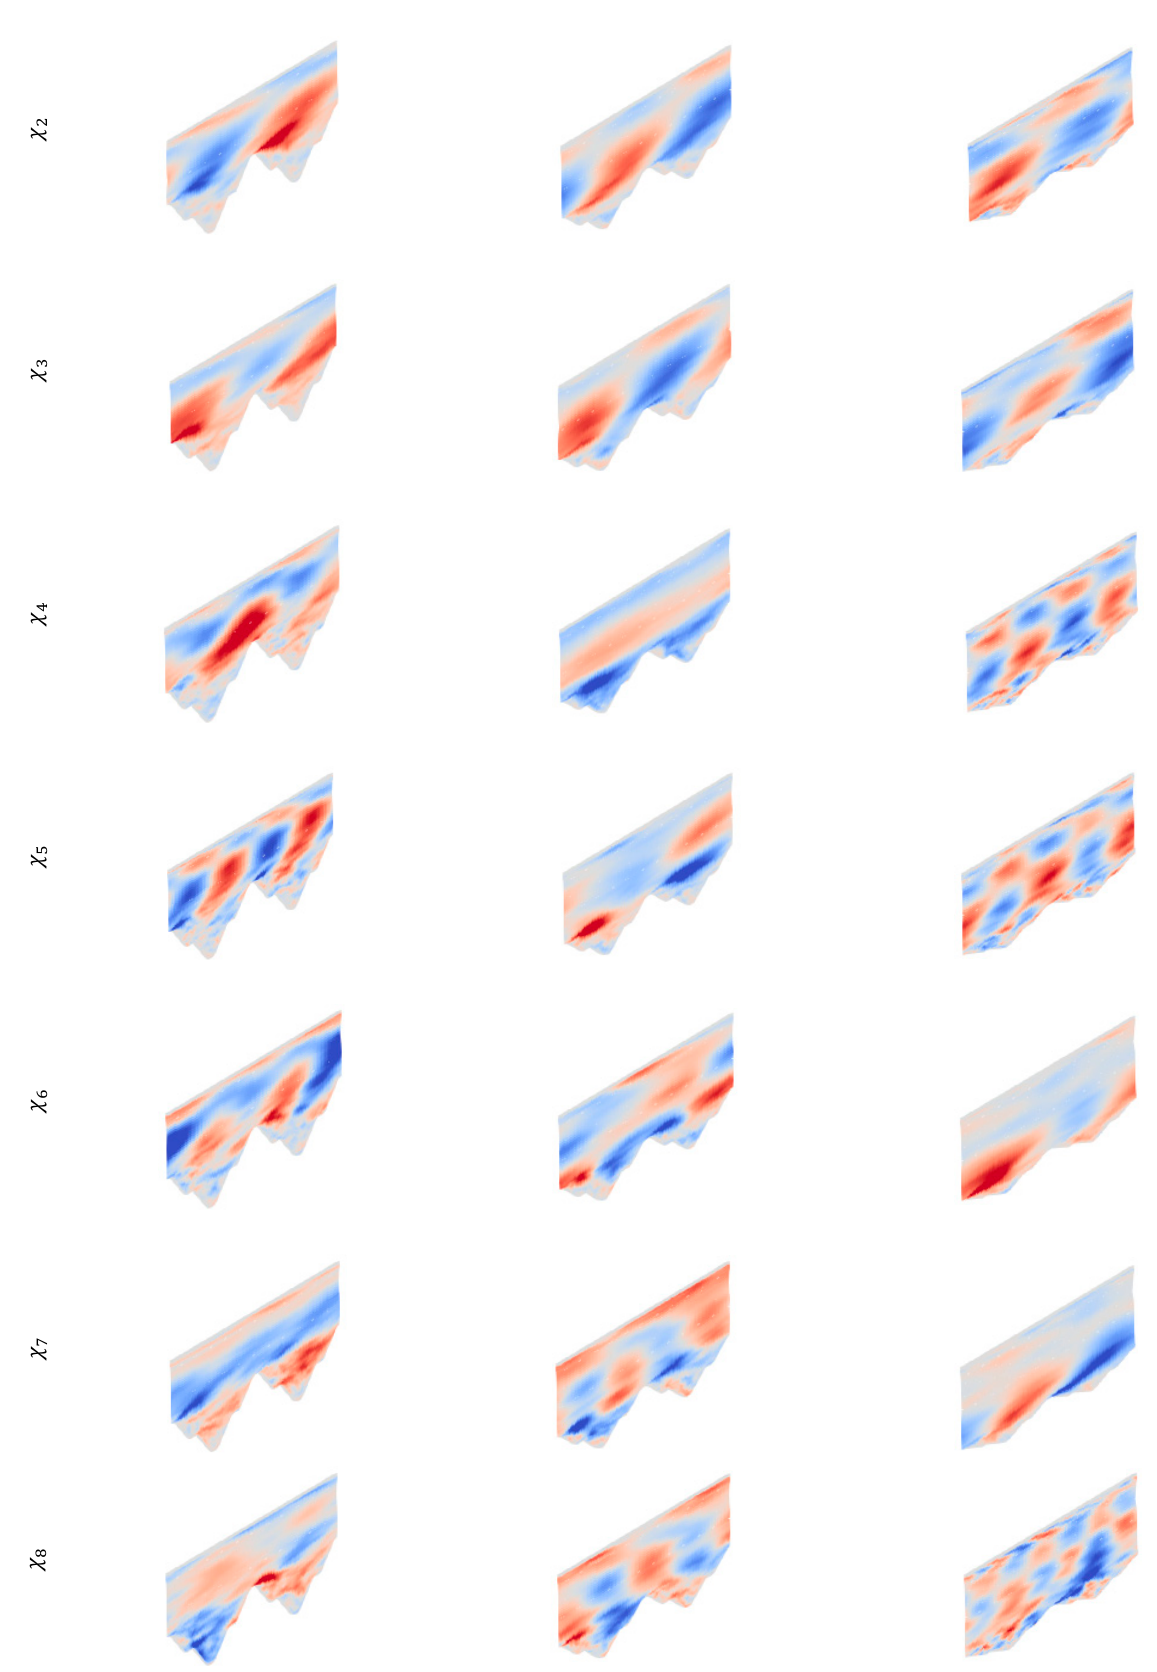
( c ) Figure 9. Front and back view of the temporal mean of the local Nu number for the three levels of roughness. ( a ) H = 60 μm ; ( b ) H = 40 μm ; and ( c ) H = 20 μm. POD is applied on the Nu field over the rough surface to evaluate the footprint of the flow and thermal fields on the heat transfer characteristics of the roughness model. Figure 10 shows the mode variance distributions and spatial POD modes of the Nu field on the surface at the three levels of roughness heights.